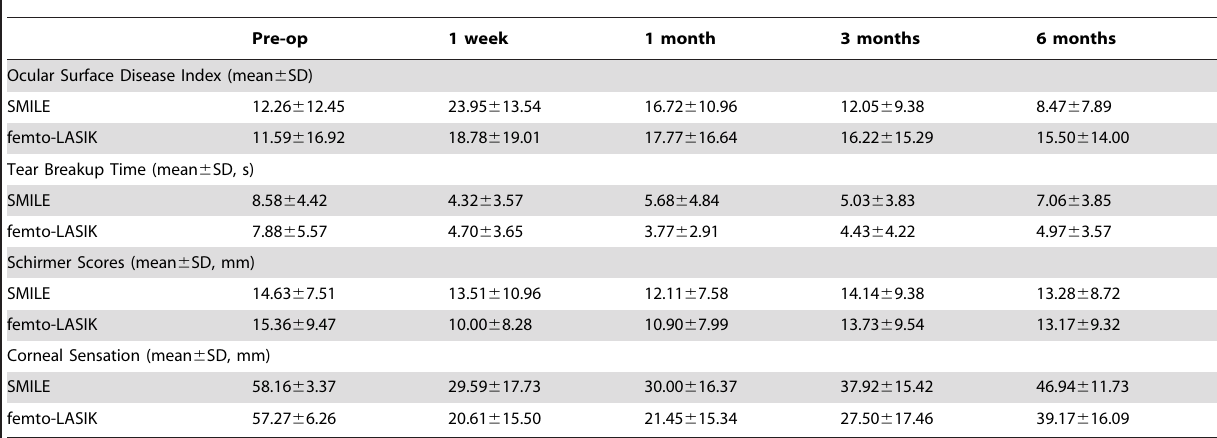
SMILE: small incision lenticule extraction. femto-LASIK: femtosecond LASIK. SD: standard deviation.